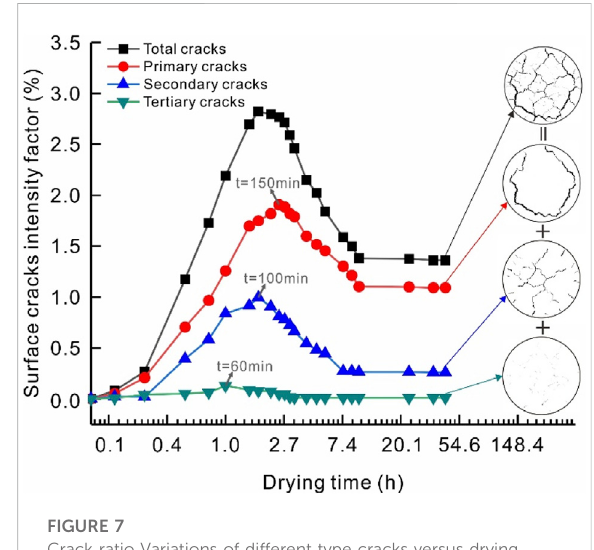
FIGURE 7 Crack ratio Variations of different type cracks versus drying time. The total crack is the sum of primary crack, secondary crack and tertiary crack.